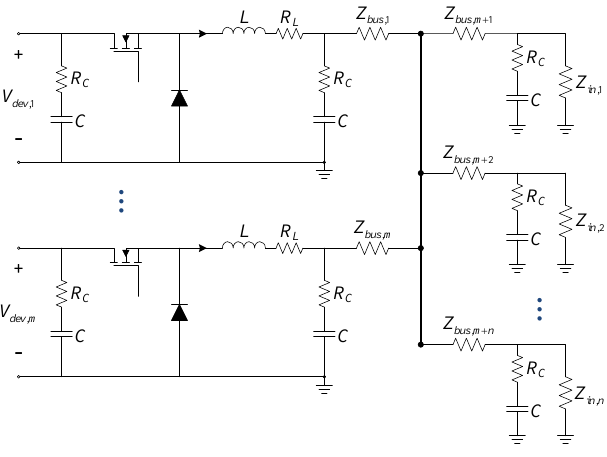
Figure 7. Circuit diagram of the bus-regulating